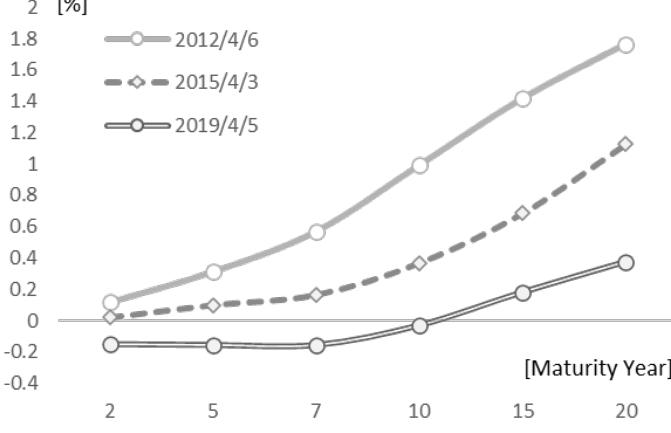
Figure 1. Japanese government bond (JGB) yield curve.